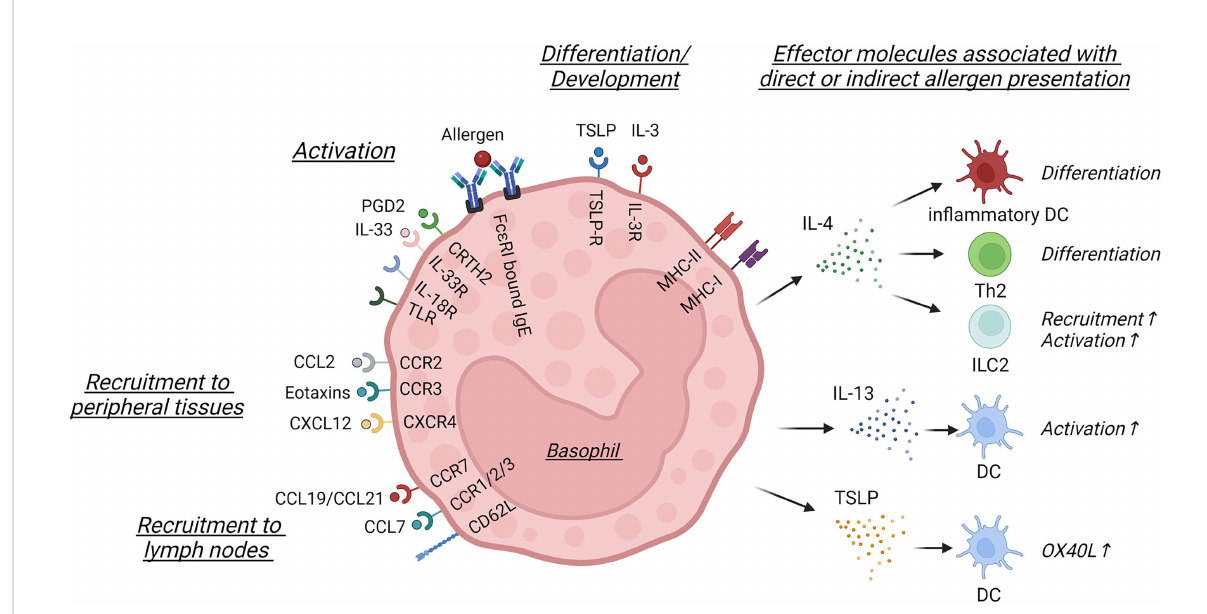
FIGURE 1 Basophil activation and effector signals involved in direct or indirect allergen presentation. In this schematic only surface and secreted molecules discussed within this review are shown. Basophil differentiation and development is controlled by TSLP and IL-3, which leads to the differential expression of cytokine and chemokine receptors, such as CRTH2, IL-33R, IL-18R, different TLRs, CCR2, CCR3 or CXCR4. Basophils can be activated by crosslinking of Fc ϵ RI-bound IgE or by different soluble mediators, such as PGD2 or IL-33. Basophils are recruited into peripheral tissues via CCL2, eotaxins or CXCL12, while CCL7 signaling or CCR7 and CD62L expression facilitate lymph node entry. While in speci fi c contexts basophils can express MHC-I and MHC-II, they are best known for the secretion of soluble mediators. IL-4 can in fl uence the differentiation of in fl ammatory dendritic cells (DC) and Th2 cells or activate innate lymphoid cell type 2 (ILC2), while IL-13 and TSLP secretion activates DC and induces OX40L upregulation, indirectly in fl uencing the priming of Th2 cells. This fi gure was created using